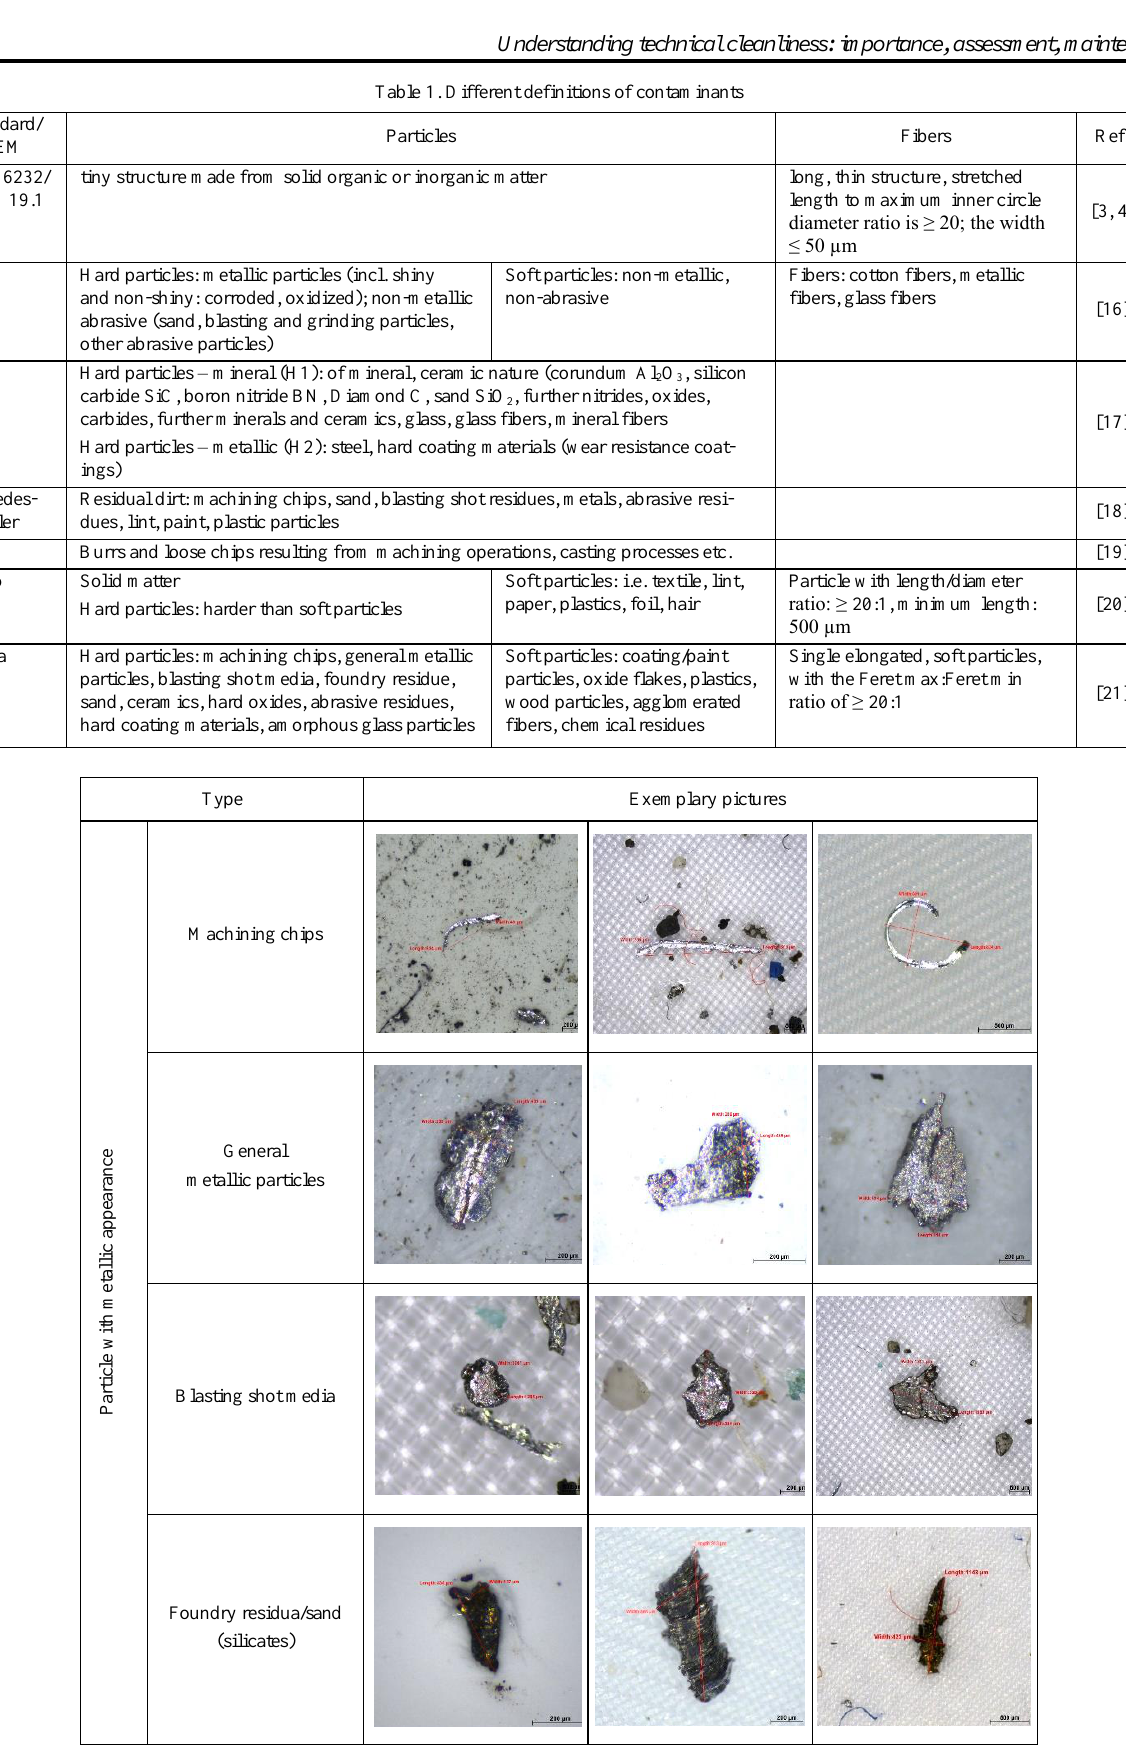
Fig. 2. Examples of hard (H)